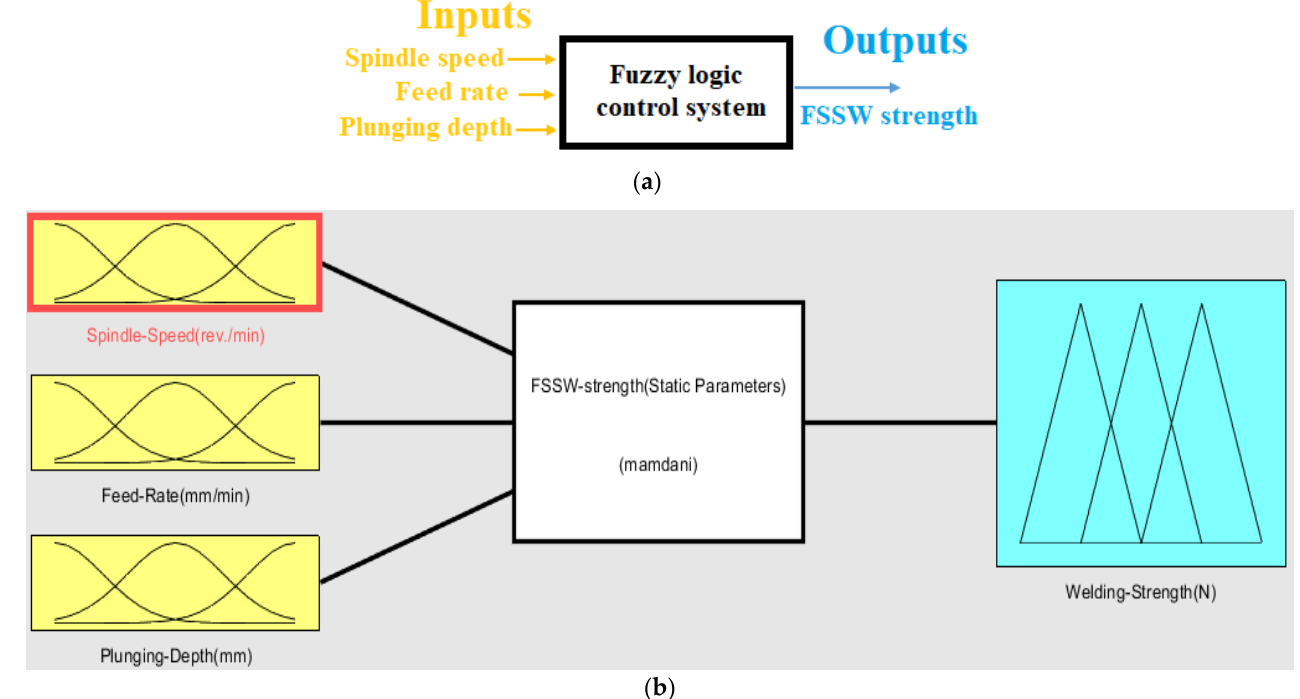
Figure 7. FSSW strength (static parameter) fuzzy logic control system ( a ) inputs and outputs ( b ) Mamdani FLCS.